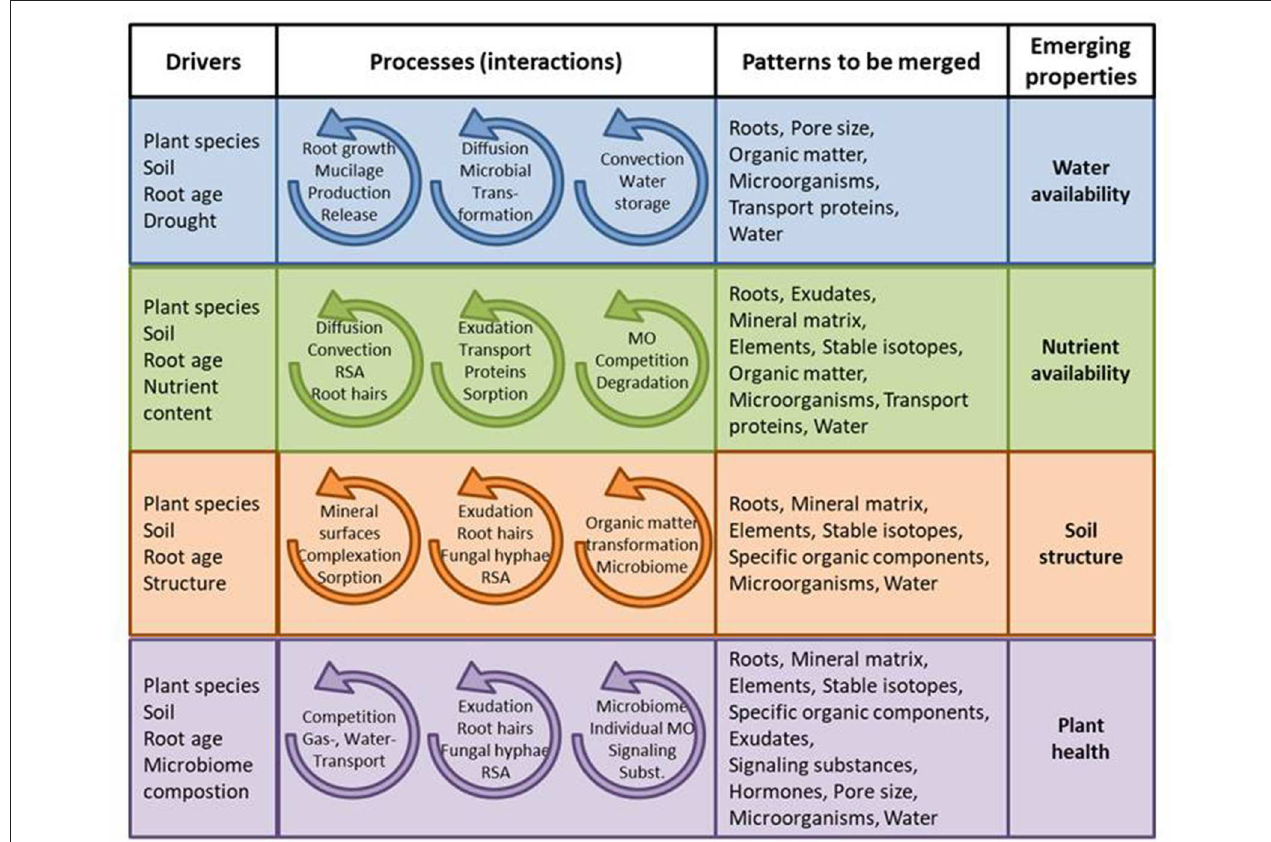
FIGURE 2 | Examples for applying the concept of self-organization to facilitate interdisciplinary research. Including qualitative and quantitative information for the parameter in question [abundance, amount, age, chemical composition, microorganisms (MO), root system architecture (RSA), size, surface properties, expression,